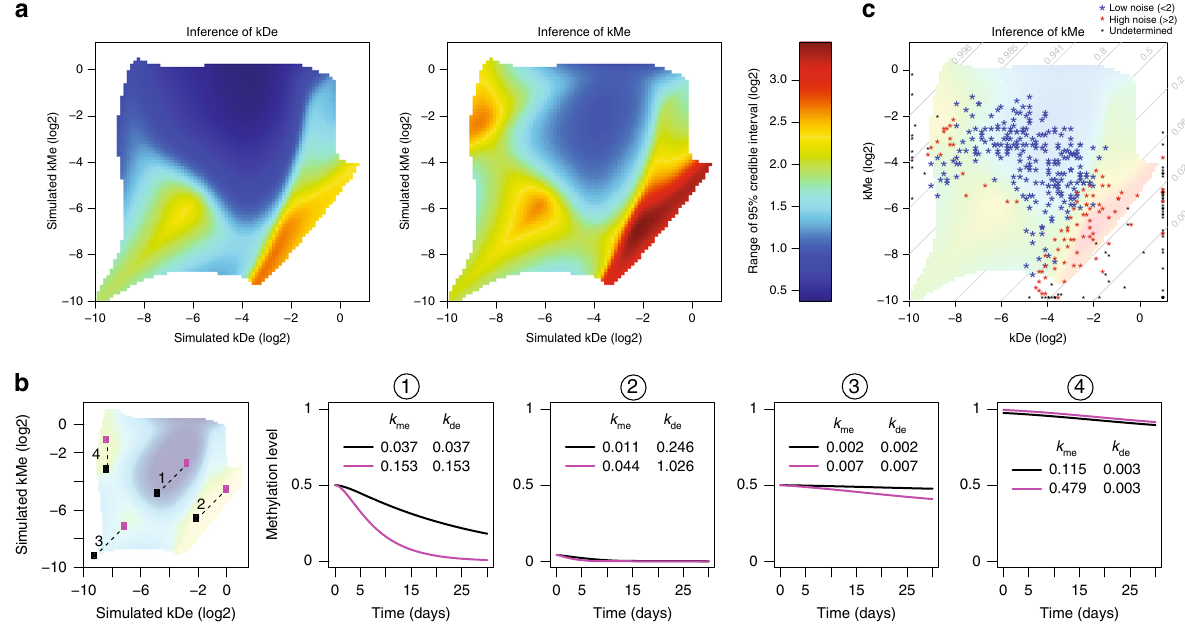
Fig. 2 The inference landscape for methylation and demethylation rates. a Inference landscape for k de (left) and k me (right), respectively, given all 6400 possible combinations tested (see “ Methods ” ). Blue regions represent high-con fi dence regimes were rates can be accurately inferred, whereas CpGs lying in the green to yellow regimes are increasingly dif fi cult and ultimately impossible to determine with high con fi dence. Con fi dence levels were determined by an error model explicitly detailed in “ Methods ” . b Example pairs of CpGs and their placement in the inference landscape. Theoretical decay curves for the point pairs (connected by dashed lines) are shown to the right. Each pair number trajectory from the far left panel is shown individually in the right four panels. Note, rates for some CpGs can be accurately distinguished (1), while others have reduced con fi dence (3) or are governed by rates that are not possible to determine (2 and 4). c Points representing rate combinations for all CpGs (405) measured with amplicon sequencing. Points are overlaid on the inference landscape taking both k de and k me into account, inference colors are as a . Blue points have low noise in rate inference, while red points represent CpGs where noise is high. Black points represent CpGs where rates cannot be determined. Because the logarithm of the rates is displayed on both axes, lines with a slope of one (cases 1 – 3) correspond to rate combinations that result in the same steady-state methylation level but with different